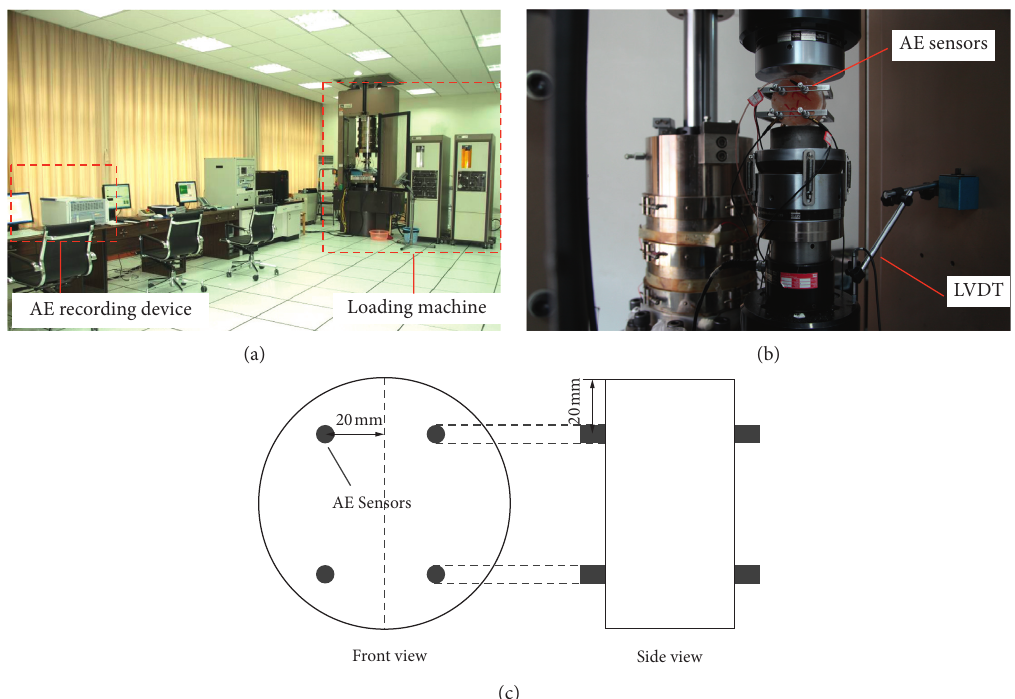
Figure 2: Testing apparatus. (a) MTS.815 rock mechanics test system. (b) Brazilian test with AE monitoring. (c) Layout coordinate diagram of AE sensors and LVDTs. Table 1: Mechanical parameters of salt rock under monotonic loading and cyclic tension.